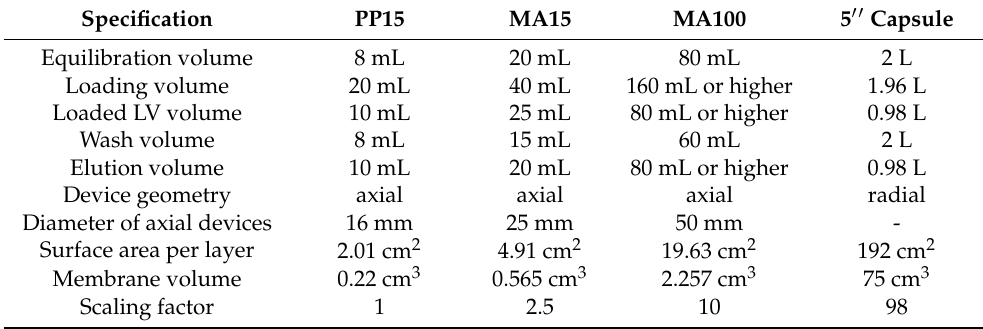
Table 1. Specifications for SXC chromatography with different device